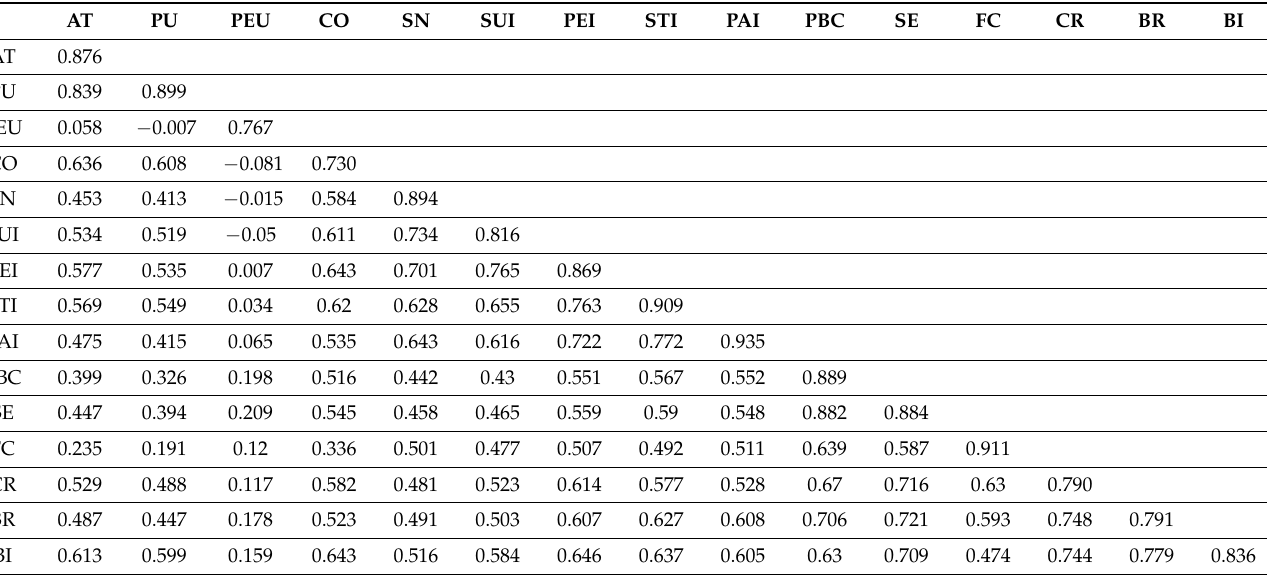
Table 5. Discriminant validity result and root of average variance